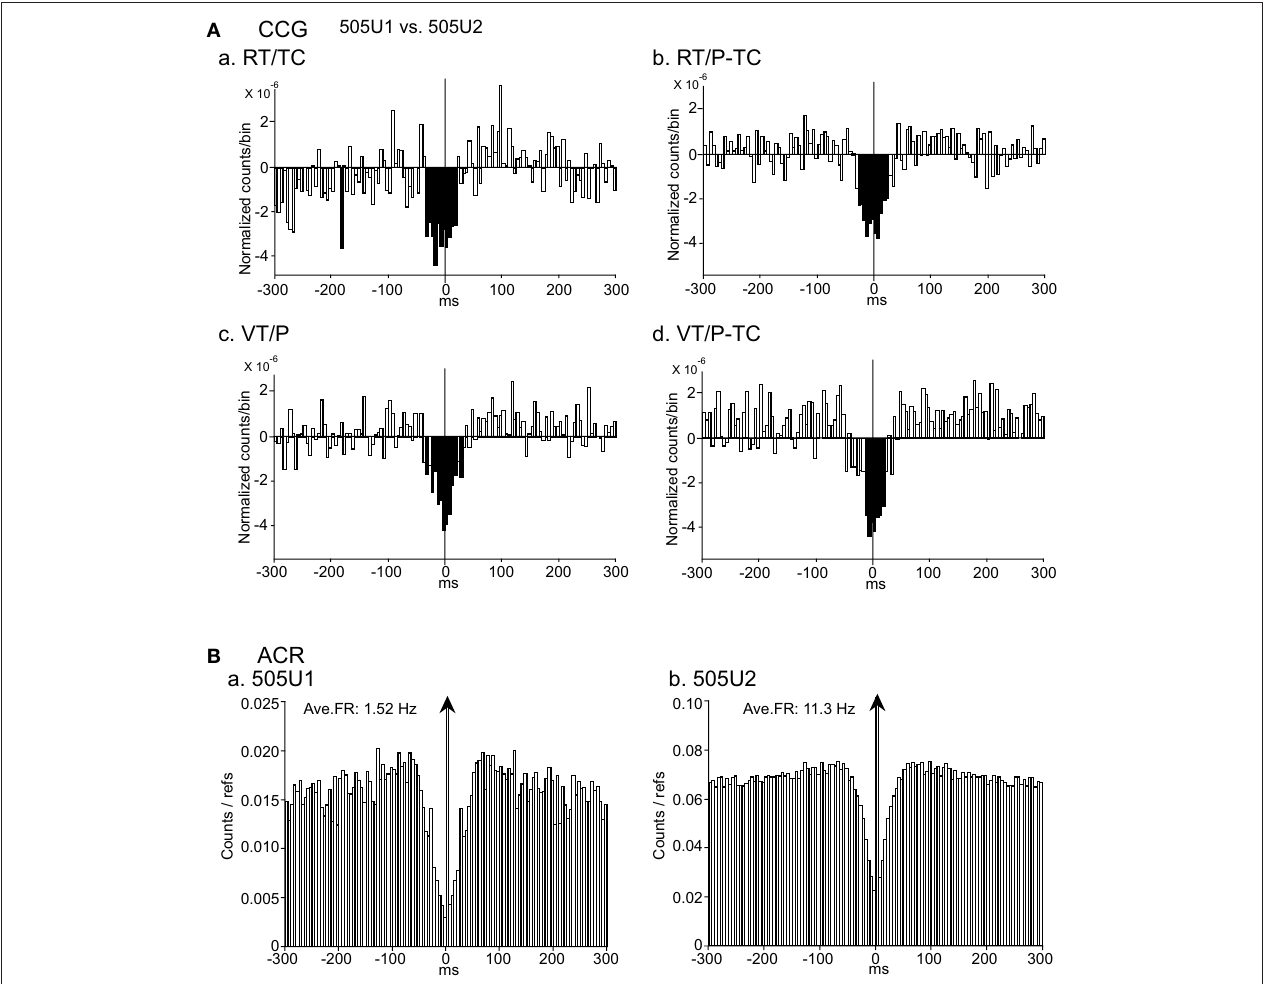
for neurons 505U1 and 505U2 were 2873 and 13900 spikes in the RT/TC, 1204 and 10187 spikes in the RT/P-TC, 1524 and 14661 spikes in the VT/P, and 1145 and 8365 spikes in the VT/P-TC tasks, respectively. (B) ACRs of the same neurons in (A) [ (a) 505U1; (b) 505U2]. Other descriptions as